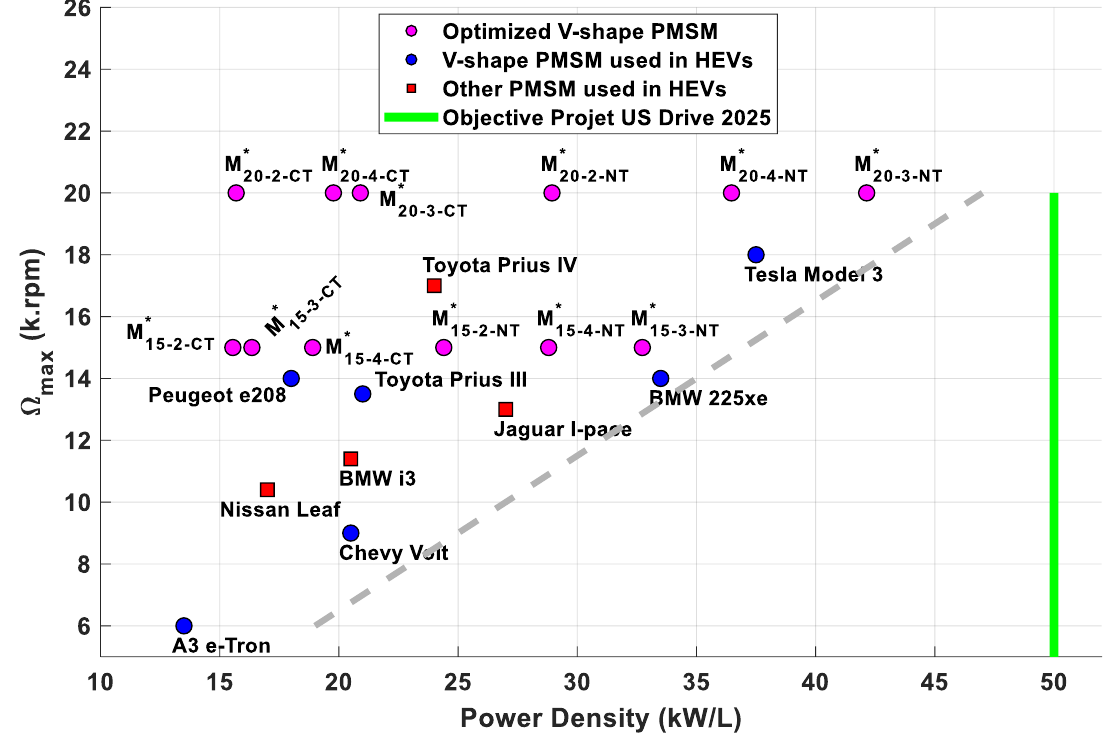
Figure 17. Maximum rotational speed vs. power density for optimal machines and other machines used in hybrid electric vehicles (HEV).